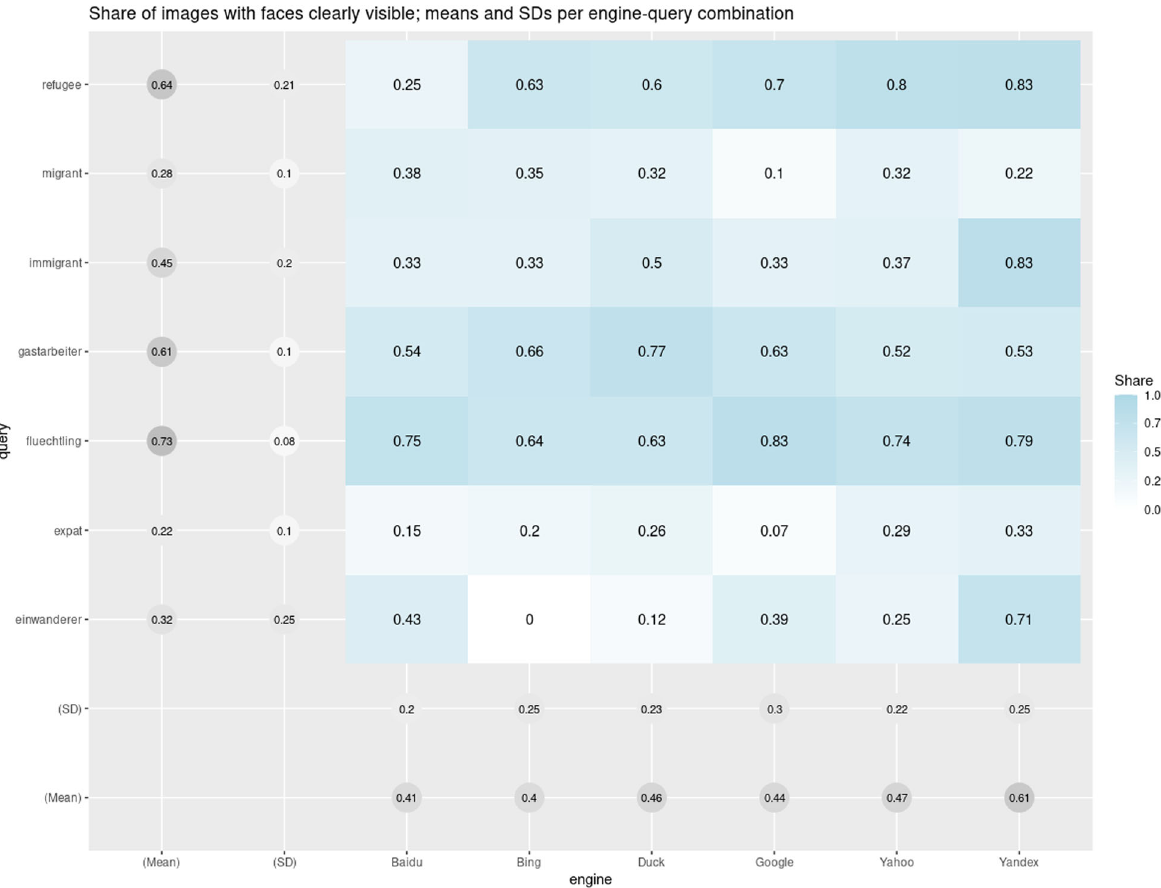
Fig. 2 Shares of images with people ’ s faces clearly visible. Share of images with people ’ s faces clearly visible by search engine and